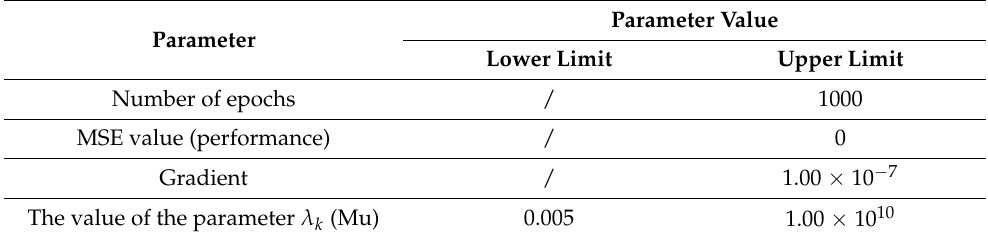
Table 9. Parameter settings applied during ANN model calibration in